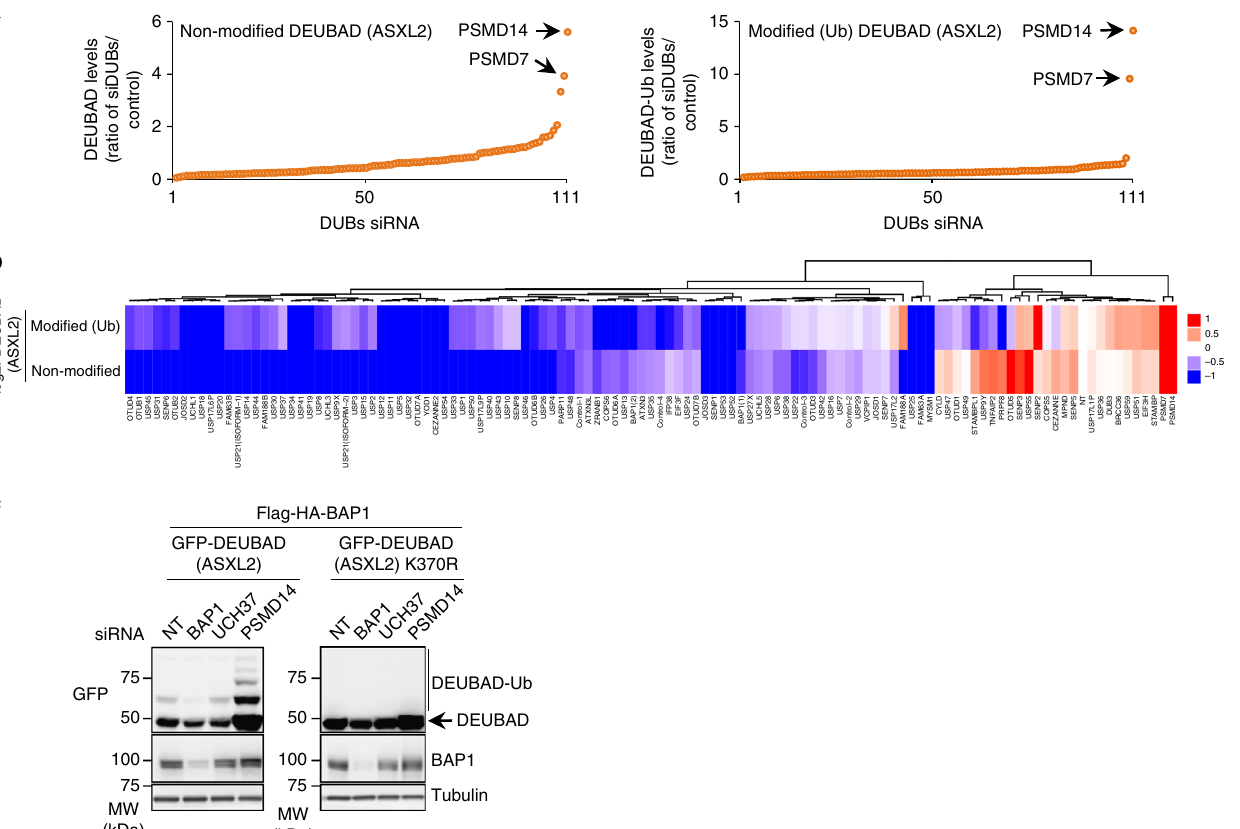
Fig. 4 K370 is the site of mono- and polyubiquitination. a DEUBAD protein levels are affected by DUB depletion. U-2 OS cells stably expressing Flag-HA- BAP1 and GFP-DEUBAD (ASXL2) were transfected with siRNA library for all human DUBs (see also Supplementary Fig. 3b). Densitometry analysis of protein bands in DUB siRNA versus non-target (NT) siRNA control were conducted. The arrows indicate the top DUBs hits that increased the corresponding protein levels. n = 1 biological sample. b Comparison of changes in band intensity between unmodi fi ed and monoubiquitinated forms of DEUBAD (ASXL2). c Validation that K370 is the site of mono- and poly-ubiquitination of DEUBAD (ASXL2). U-2 OS cells stably expressing Flag-HA-BAP1 and either GFP-DEUBAD (ASXL2) or GFP-DEUBAD (ASXL2) K370R were transfected with siRNA NT control or siRNAs targeting different DUBs and harvested for western blotting as indicated. n = 2 biological replicates. Tubulin was used as a loading control for panel